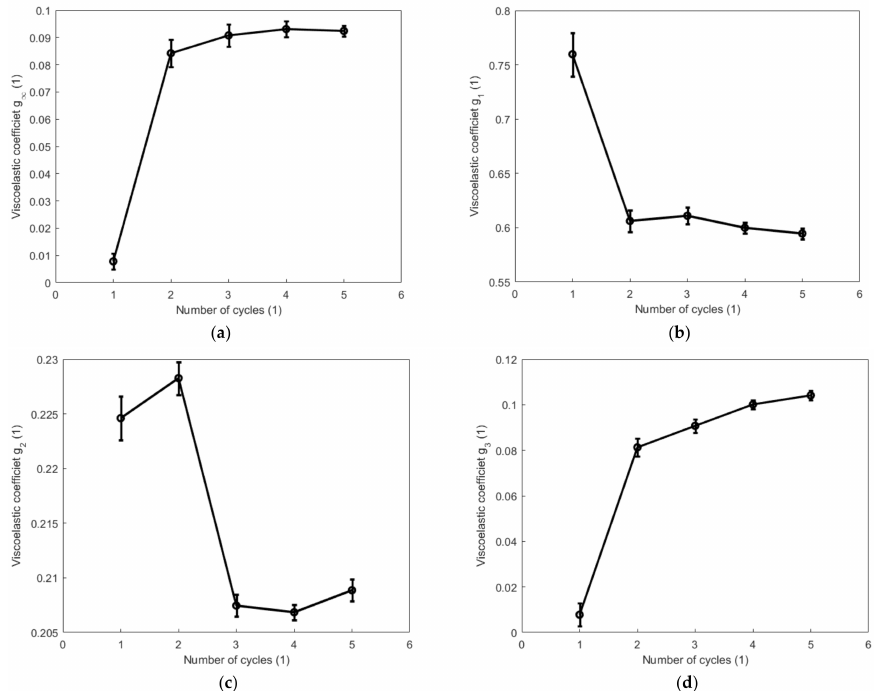
Figure 15. Evolutions of viscoelastic coefficients g ∞ , g 1 , g 2 , and g 3 with respect to the number of cycles during the cyclic tension process: ( a ) g ∞ ; ( b ) g 1 ; ( c ) g 2 , and ( d ) g 3 .